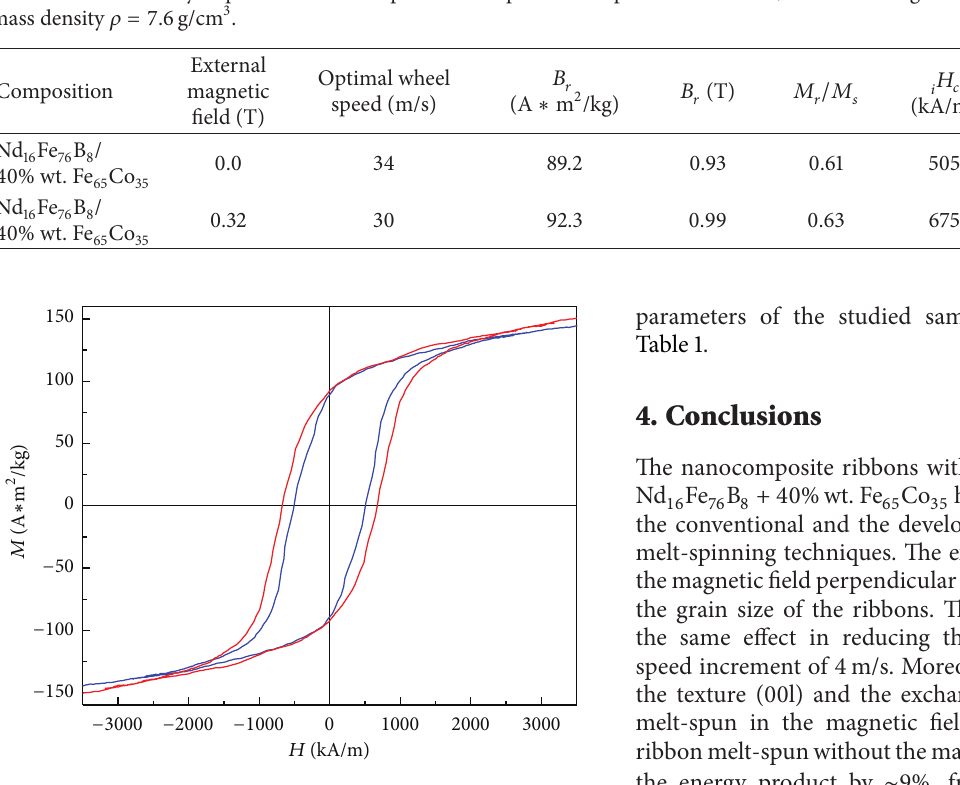
Figure 4: Hysteresis loops of Nd 16 Fe 76 B 8 /40%wt. Fe 65 Co 35 samples with and without a magnetic field. Blue line is 𝑀(𝐻) of ribbons with = 0 T and V = 34 m/s and red line is 𝑀(𝐻) of ribbons with 𝐻 ext opt = 0.32 T and V = 30 𝐻 ext opt